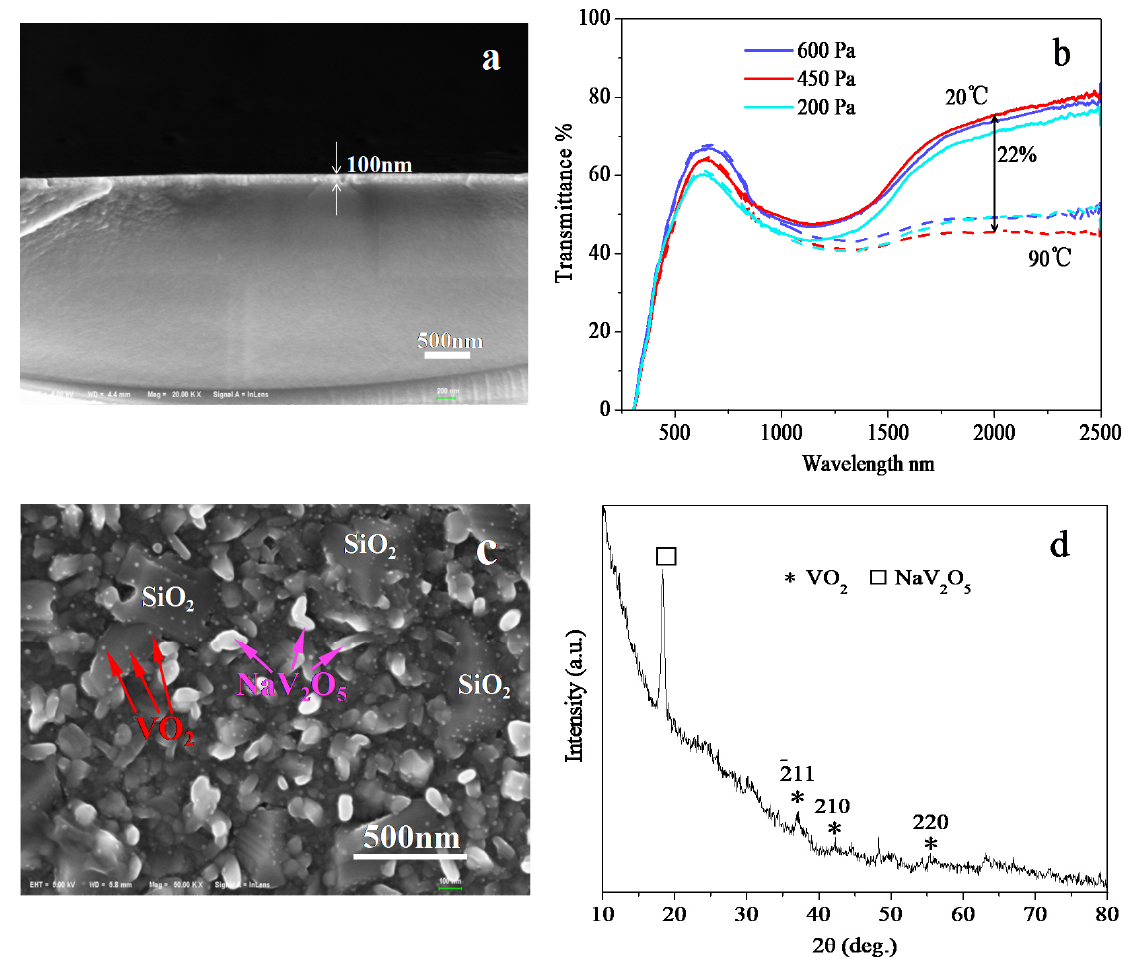
Figure 8. Cross-sectional SEM image of the intermediate SiO 2 layer ( a ); transmittance curves of VO 2 thin films on SiO 2 prepared by professional annealing of 30 nm V at different pressures ( b ); SEM ( c ) and XRD ( d ) patterns of the VO 2 thin film on SiO 2 prepared by professional annealing of 30 nm V at 450 Pa; all at 400 °C for 1 h.